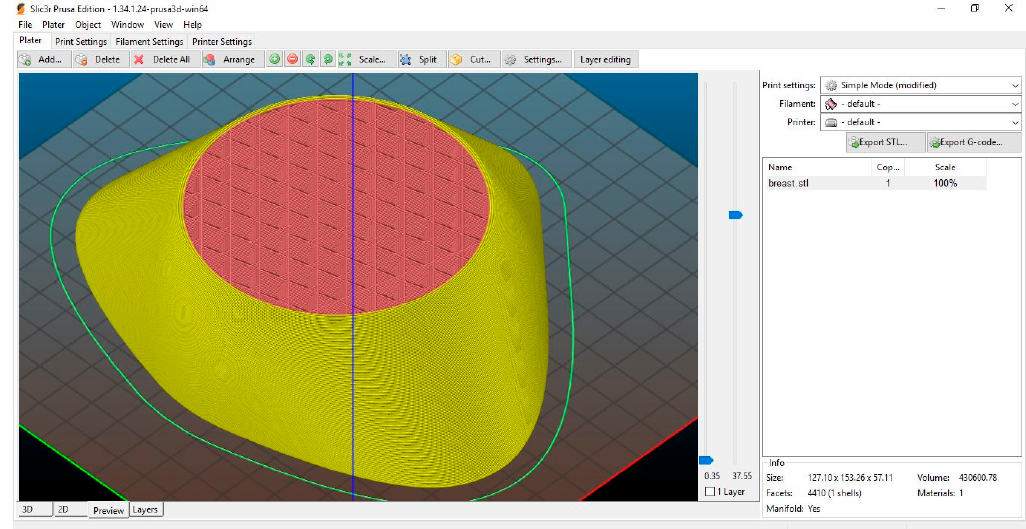
Figure 7. Changing infill (red) of the prosthetic breast model in Slic3r Prusa Edition. The wall or skin (yellow) has no z step line.